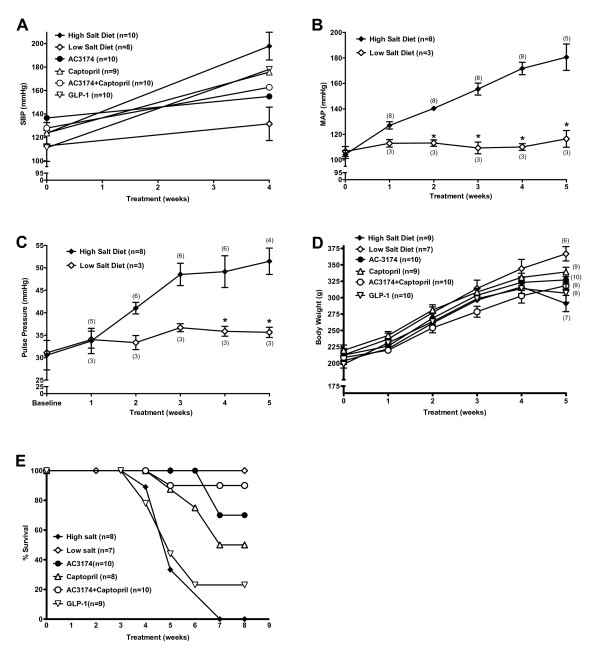
Development of hypertension in the DSS rat over 4 or 5 weeks of high (8% NaCl) or low (0.3% NaCl) salt diet. (A) Systolic blood pressure measured by tail cuff. No difference among groups at baseline. At week 4, systolic blood pressure was significantly lower in all groups compared with a high salt diet alone (P ≤ 0.05). The pooled-over-time mean of the low salt group was significantly different from the high salt group (p < 0.003) (B) Arterial blood pressure measured by implanted transmitter. *P ≤ 0.05 versus high salt diet alone. (C) Pulse pressure measured by implanted transmitter. *P ≤ 0.05 versus high salt diet alone. (D) Change in body weight. (E) Kaplan-Meier survival curves followed for 8 weeks. N = 7 to 10 rats per group (N = 3 to 8 for telemetry data). Mean ± SEM.